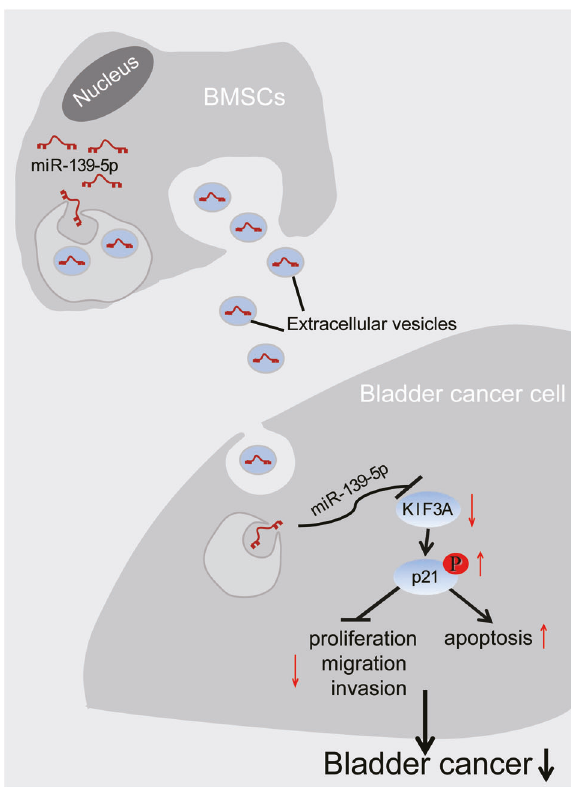
Fig. 8 Molecular mechanisms of our study. Mechanism diagram showing that miR-139-5p delivered by BMSCs-EVs attenuates the progression of bladder cancer through suppression of KIF3A and activation of